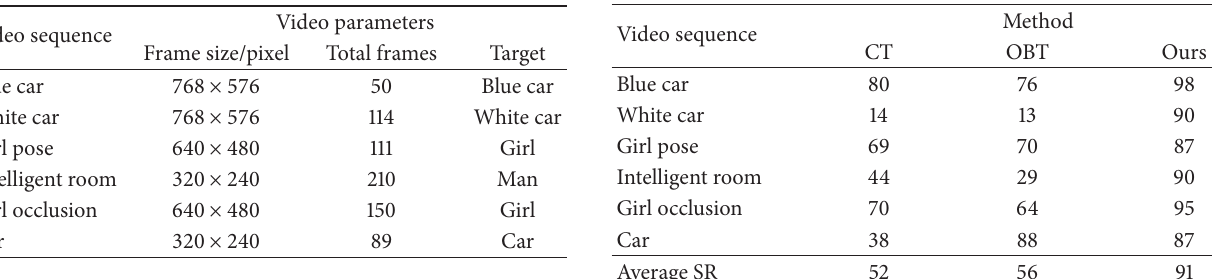
Table 1: Video parameters.